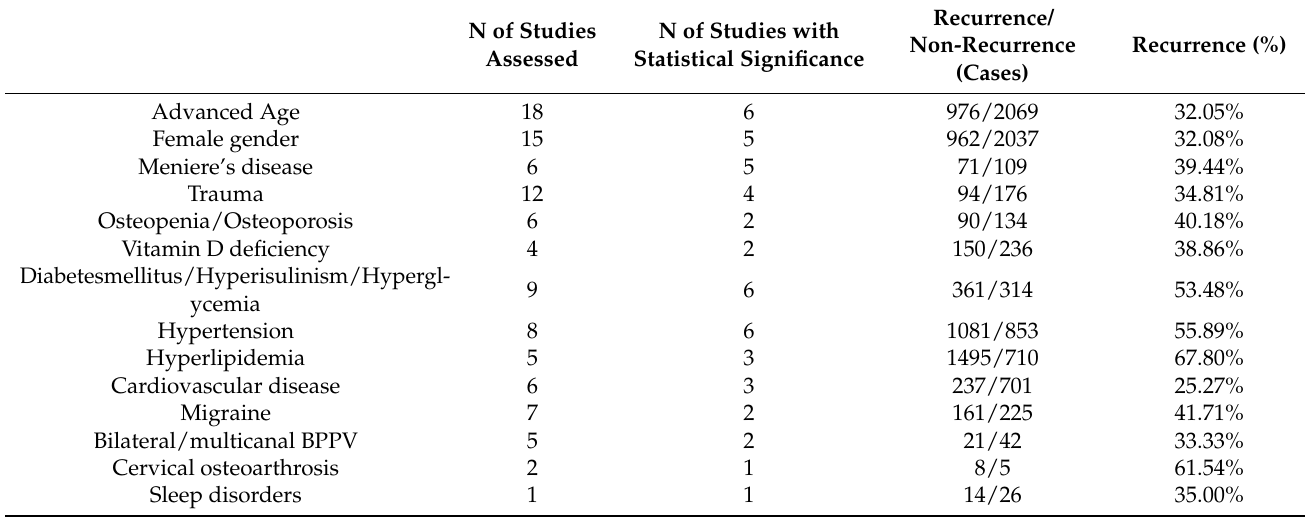
Table 2. Analysis of each included risk factor for BPPV recurrence in this